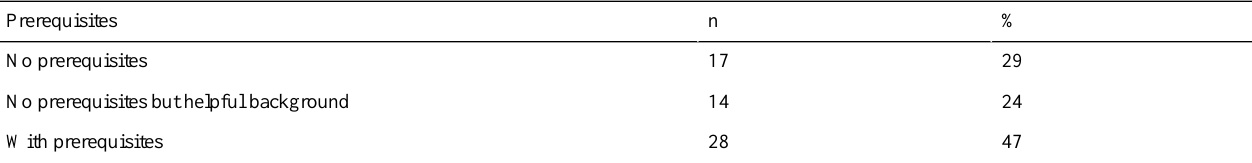
Table 8. Prerequisites in MOOC descriptions